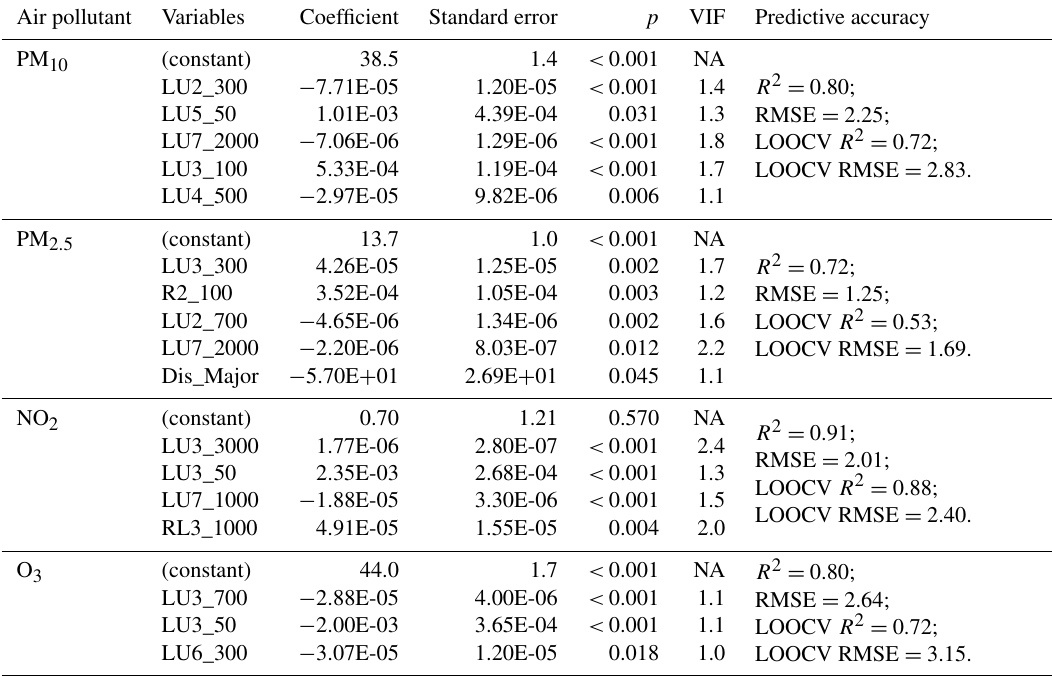
Table 2. Description of the 2019 annual-average LUR models for ambient PM 10 , PM 2 . 5 , NO 2 and O 3 in the TKMA. Air pollutant Variables Coefficient Standard error p VIF Predictive accuracy PM 10 (constant)